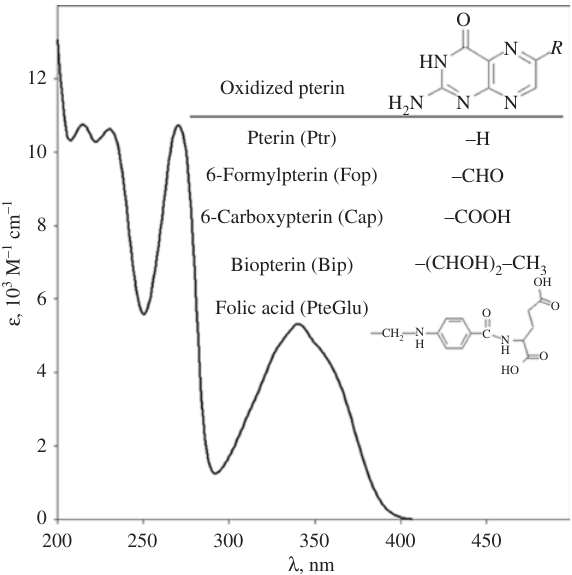
Figure 1: Molecular structures of common aromatic pterin deriva- tives and the absorption spectrum of pterin (Ptr) in air equilibrated aqueous solution at pH =